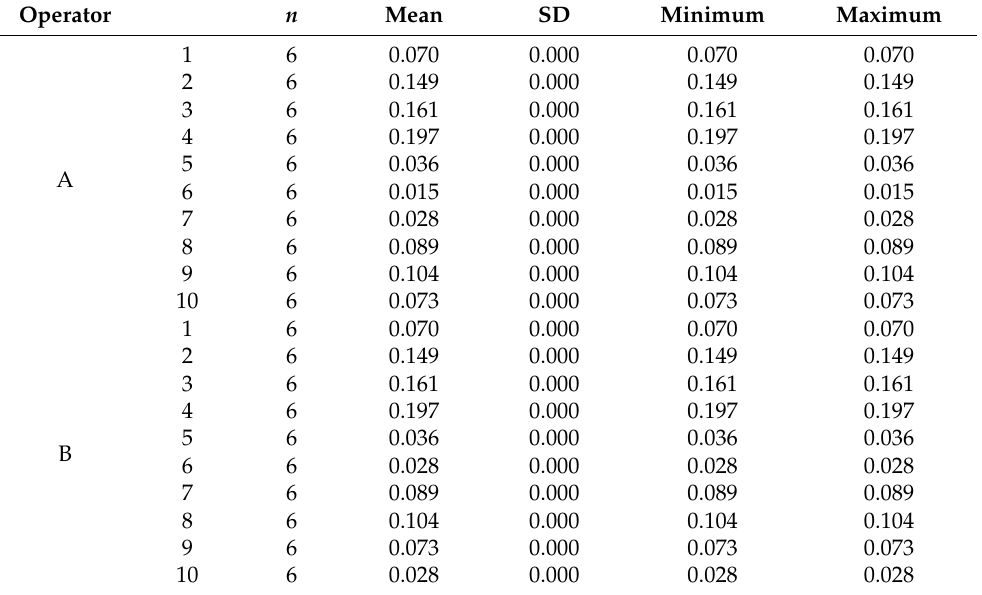
Table 1. Quantitative statistics regarding the wear volume (mm 3 ) of the CM-wire NiTi alloy endodon- tic reciprocating files between the